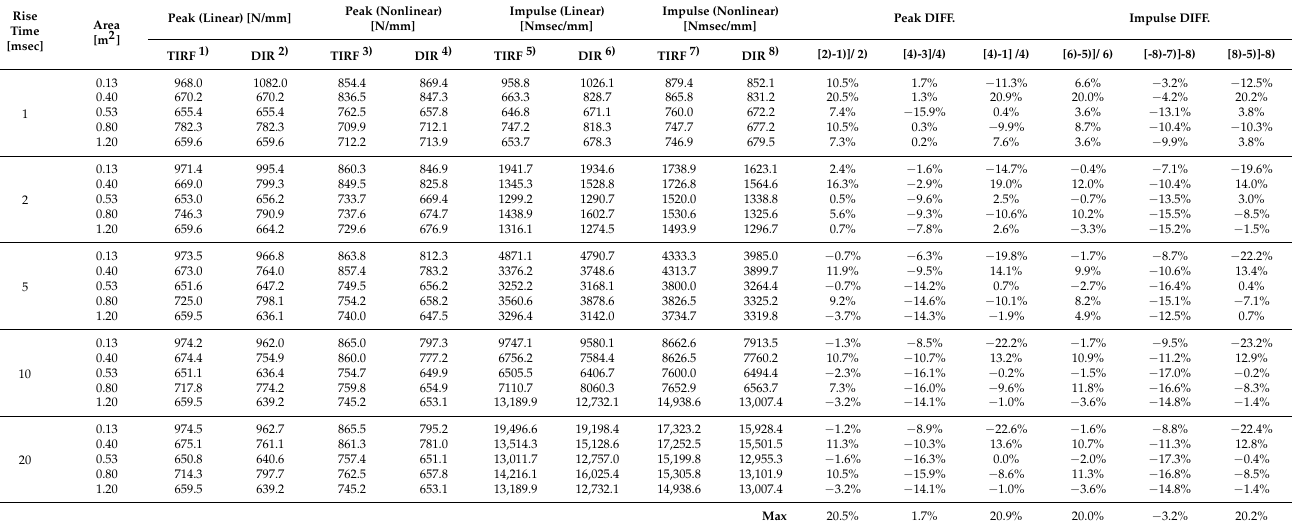
Table 10. Bending responses for LNG cargo containment boxes with hull structure (Model